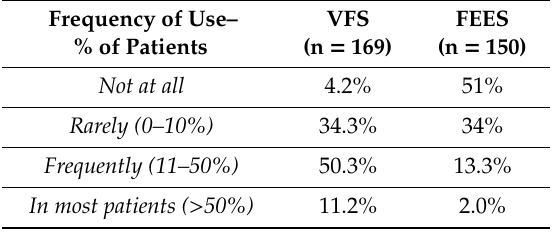
Table 2. Frequency of use for videofluoroscopy (VFS) and fibreoptic endoscopic evaluations of swallowing